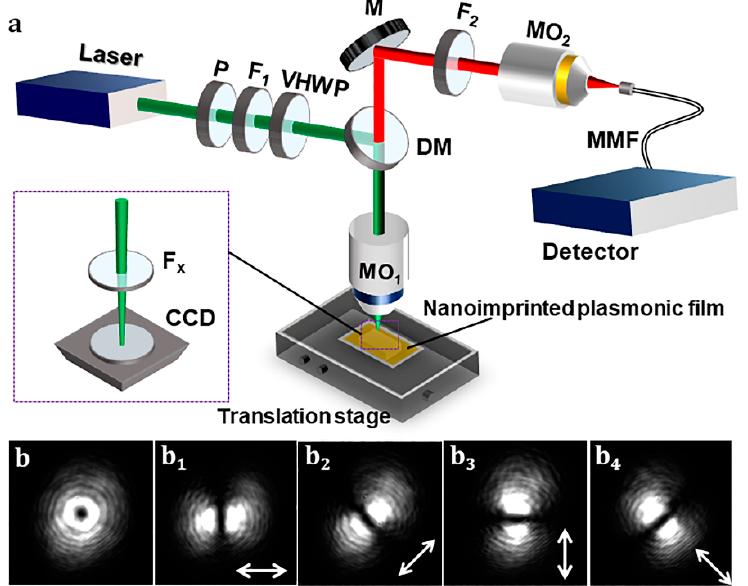
Figure 2. ( a ) Sketch map of the MEF examination system based on the nanoimprinted plasmonic fi lms. ( b ) Energy distribution on the beam cross-section of RVB generated by VHWP, and the corresponding polarization testing results ( b 1 – b 4 ), which are obtained by rotating the polarization plate F x . The arrows indicate the transmi tt able polarization direction of F x .